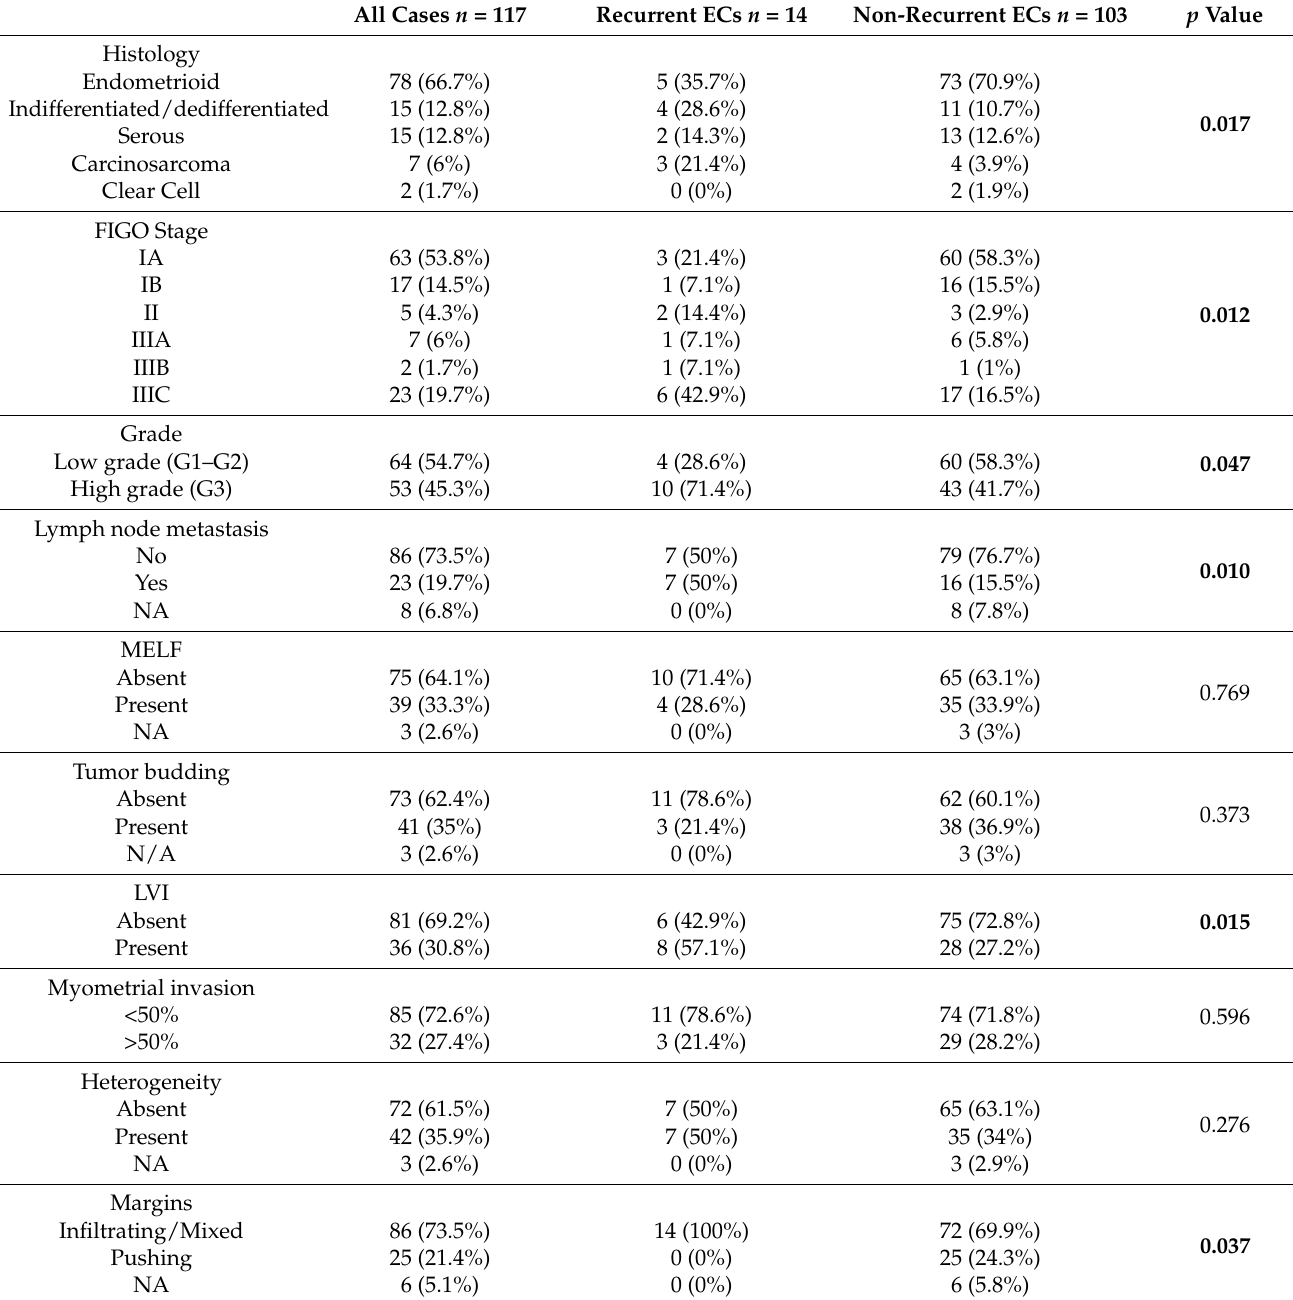
FIGO: International Federation of Gynaecology and Obstetrics; G: grade; LVI: lymph-vascular space invasion; MELF: microcystic, elongated, and fragmented; NA: not available. Bold highlights the statistical significance. Histology was significantly different between the two groups, with the endometroid type being more common in the non-recurrent ECs (70.9%), whereas carcinosarcoma was more frequent in recurrent ECs (35.7%), p = 0.014. FIGO stage was significantly associated with recurrence; in particular, the majority of recurrent ECs were classified as stage III ( n = 8, 57.1%) [IIIA n = 1, 7.1%; IIIB n = 1, 7.1%; IIIC n = 6, 2.9%], but this was not the case in non-recurrent ECs ( n = 24, 23.3%) [IIIA n = 6, 5.8%; IIIB n = 1, 1%; IIIC n = 17, 16.5%]; on the contrary, n = 76 (73.8%) of non-recurrent ECs were in stage I, versus 28.5% among recurrent ECs, p = 0.002. Similarly, grade was significantly associated with recurrence (low grade (G1–2): 28.6% vs. 58.3%; high grade (G3): 71.4% vs. 41.7%, in recurrent